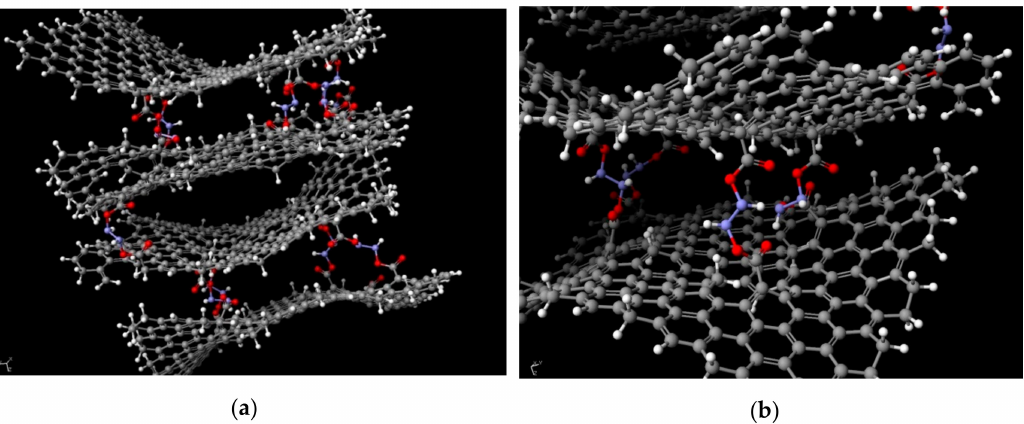
Figure 9. ( a , b ) The modelled 3D structure of cross-linked systems based on graphene oxide flakes. The balls colored in gray represent carbon atoms, white—hydrogen, red—oxygen, and